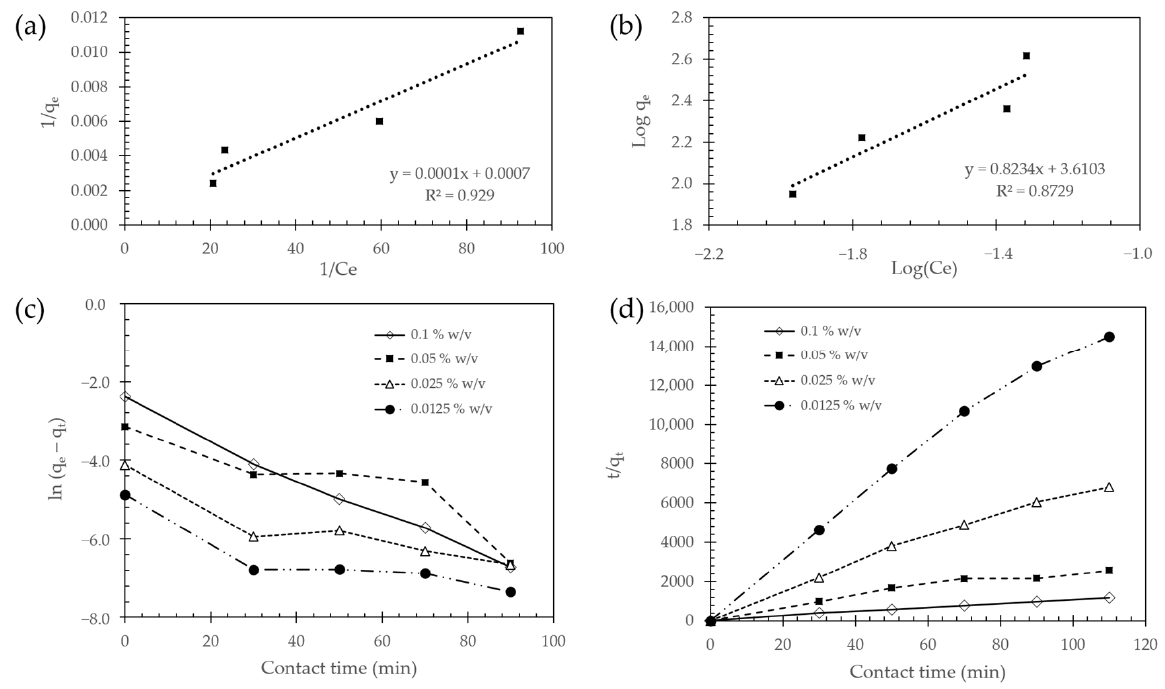
Figure 6. Linearized ( a ) Langmuir and ( b ) Freundlich adsorption isotherms of Fe 3 O 4 NPs @APTES at 18°C; ( c ) pseudo- first-order (PFO) and ( d ) pseudo-second-order (PSO) kinetic plots for Cd adsorption with Fe 3 O 4 NPs @APTES.